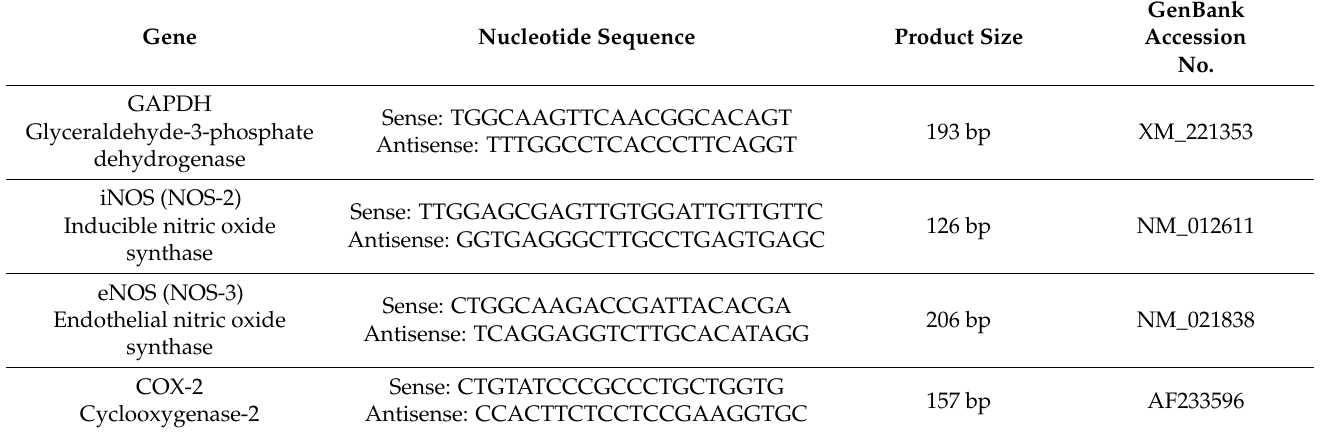
Table 1. GAPDH, iNOS, eNOS and COX-2